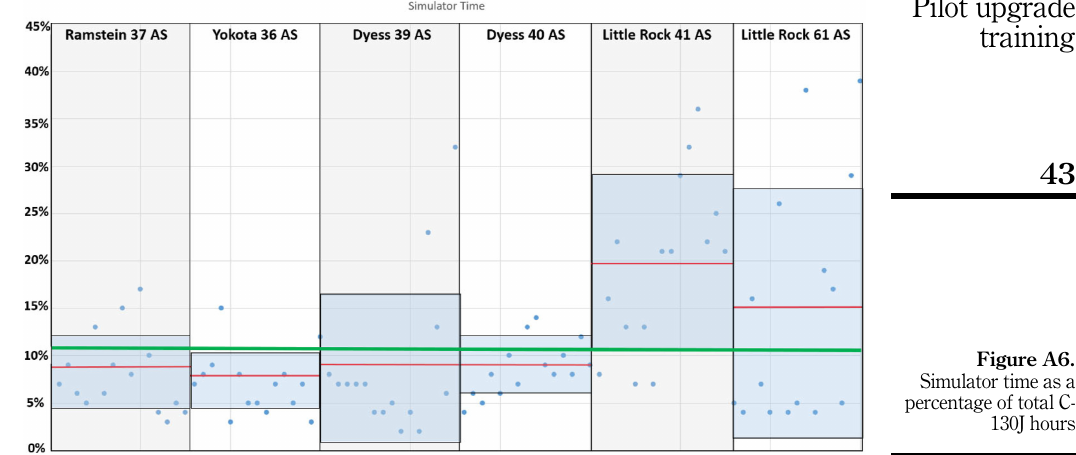
Figure A6. Simulator time as a